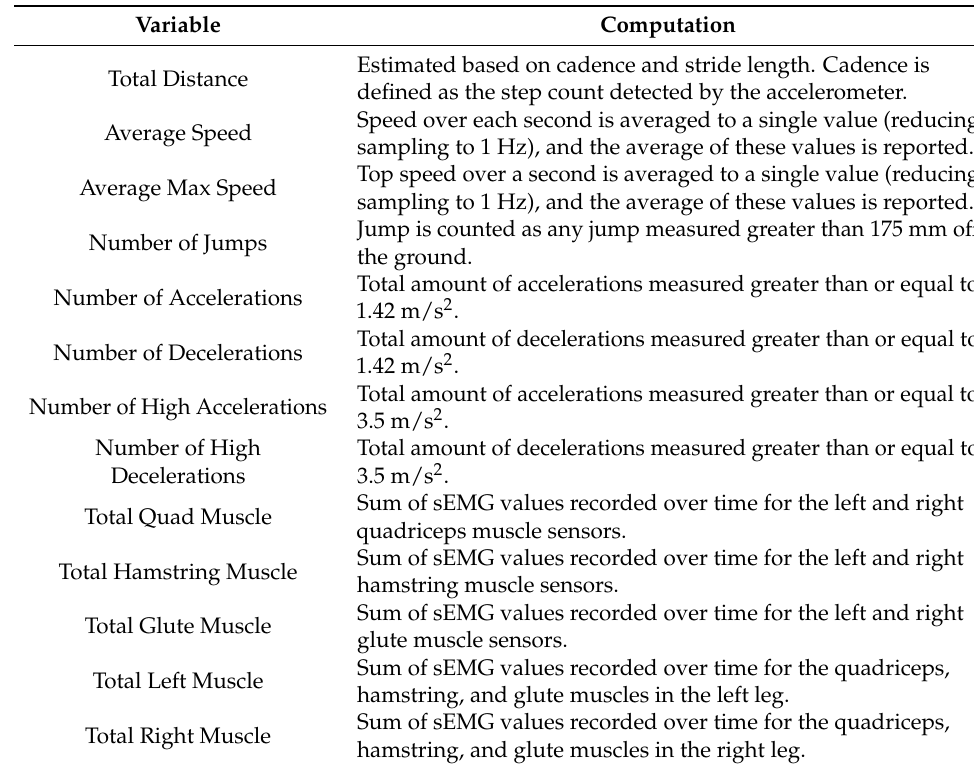
Table 1. List of descriptions for each of the load variables used for analysis. Variable